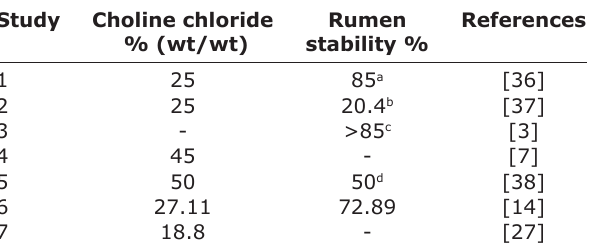
Table-2: Description of RPC used in the different studies. Study